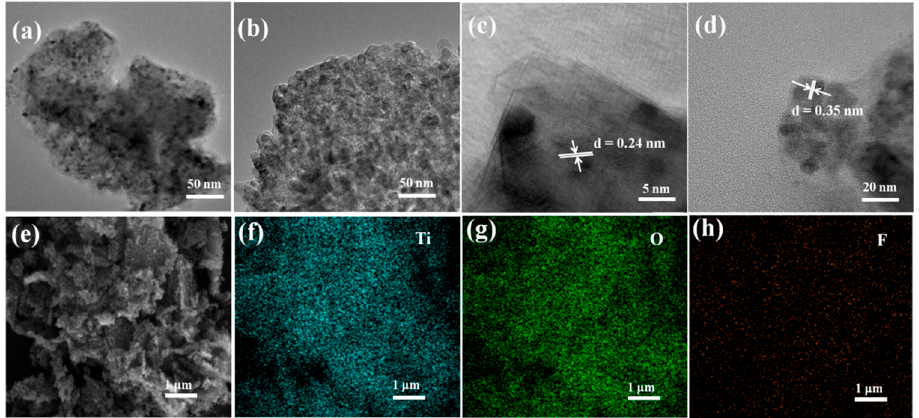
Figure 1. HRTEM images ( a – d ) and elemental mappings ( e – h ) of the plate-like TiO 2 sam-